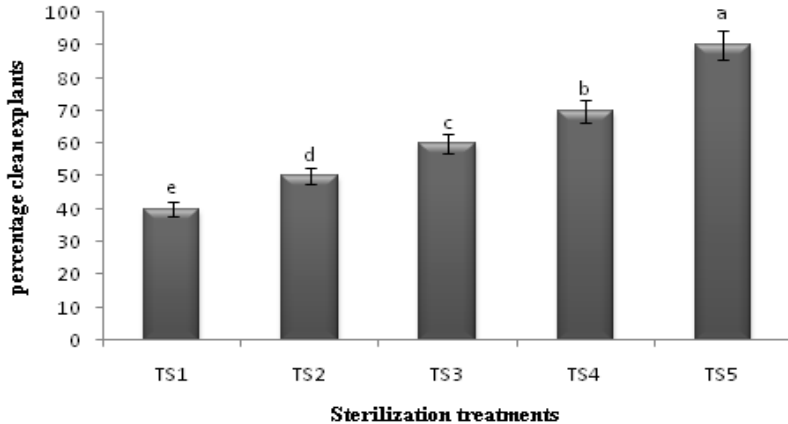
Figure 2. Effects of different surface sterilization methods on percentage of clean culture of C.asiatica n = 4 ( TS1 = decon + benomyl (dip explants 20 min) + clorox 15% and 10% (15 and 10 min respectively); TS2 = TS1 + benomyl 100 mg/L in medium; TS3 = Decon + benomyl + Clorox 15%, 12 min + PPM in medium 2 mL/L; TS4 = TS3 + soak in PPM 2% for 1 hour; TS5 = Decon + cetrimide 1% + bavistin 150 mg/L + trimethoprim 50 mg/L + HgCl 0.1% + PPM 2% soak and 2 mL/L in 2